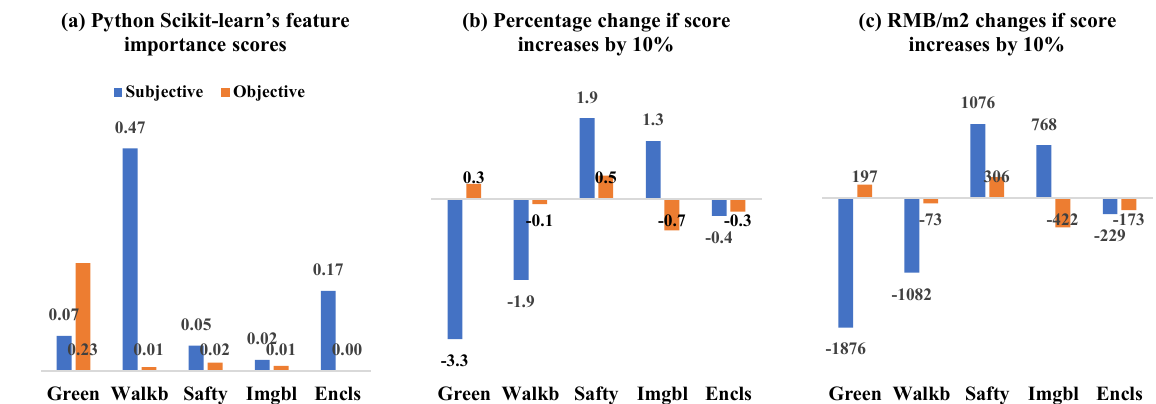
Figure 11. Comparing subjective and objective streetscape scores in ( a ) global importance ranking, ( b ) impact on housing price percentage changes and ( c ) per square meter price change if score increases by 10%.